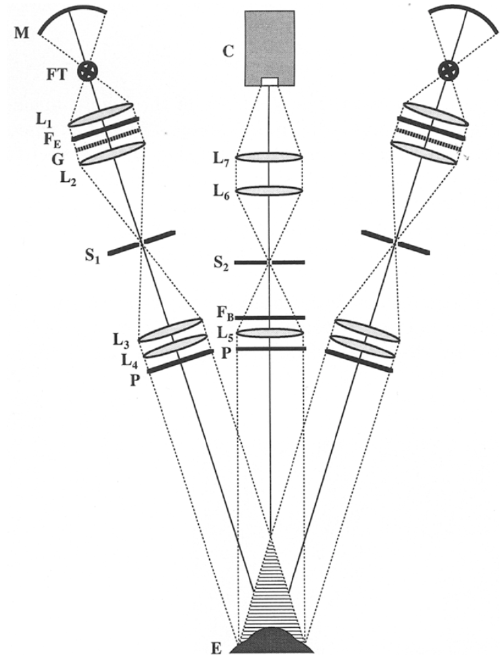
Figure 8. Optical schematic of the Maastricht Topographer [65].